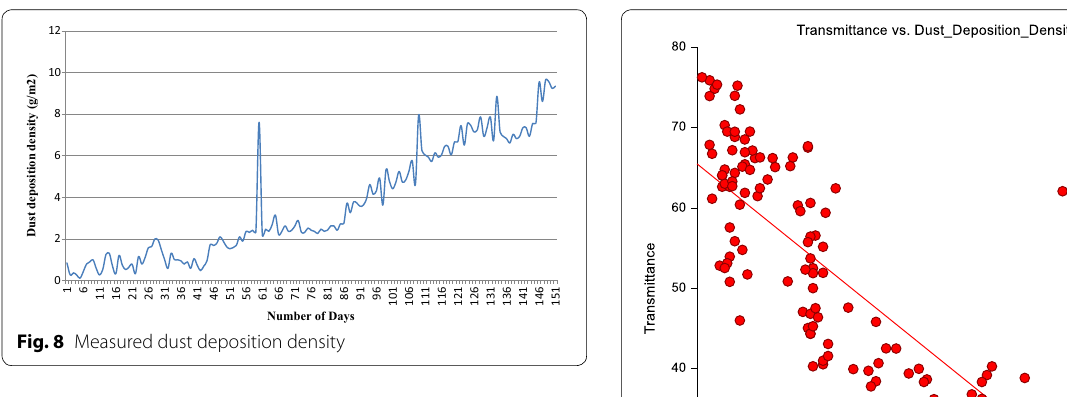
τ ∗ 100. τ c (cid:30)